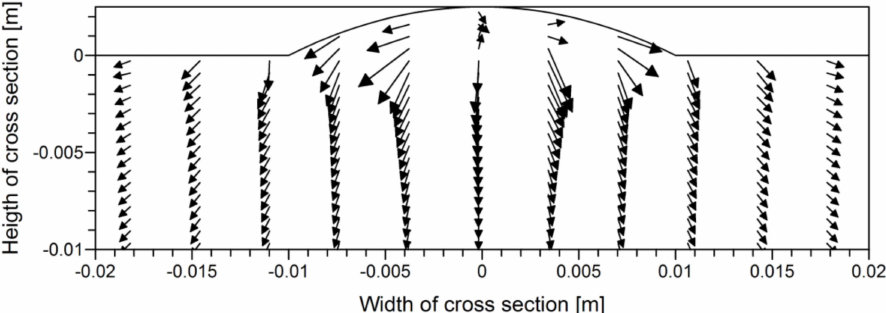
Figure 17. Field of calculated cooling velocity vectors in padded weld area.